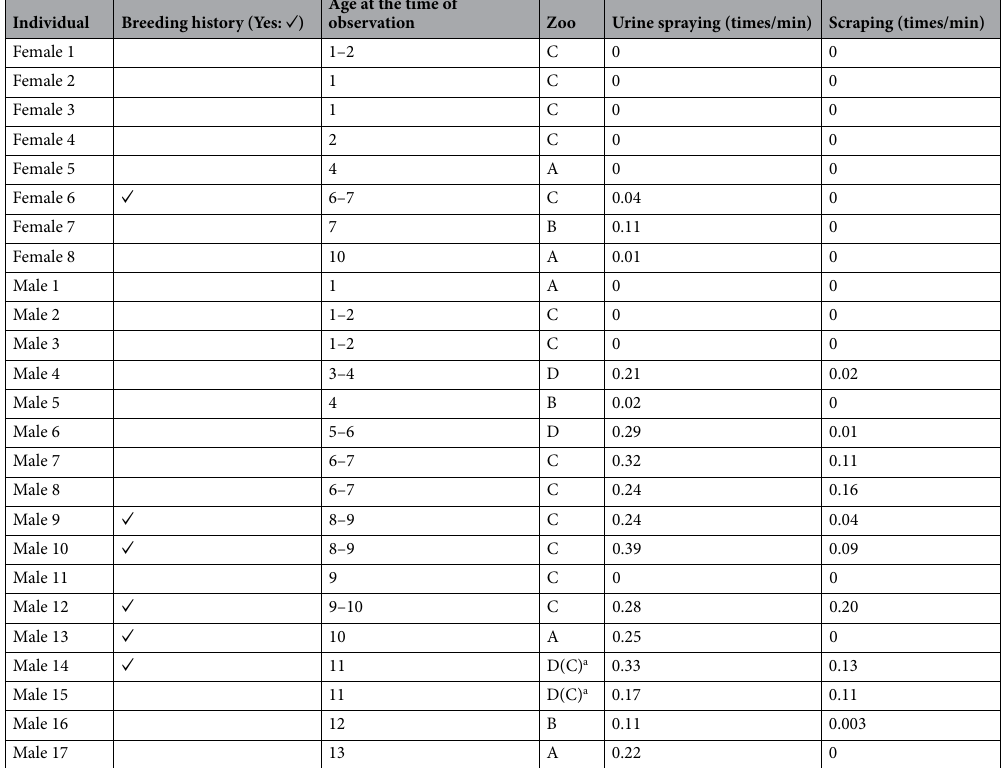
Table 2. Frequency of urine spraying and scraping using hind paws observed in captive cheetahs for 25 min after release into enclosures. a Moved on July 17,